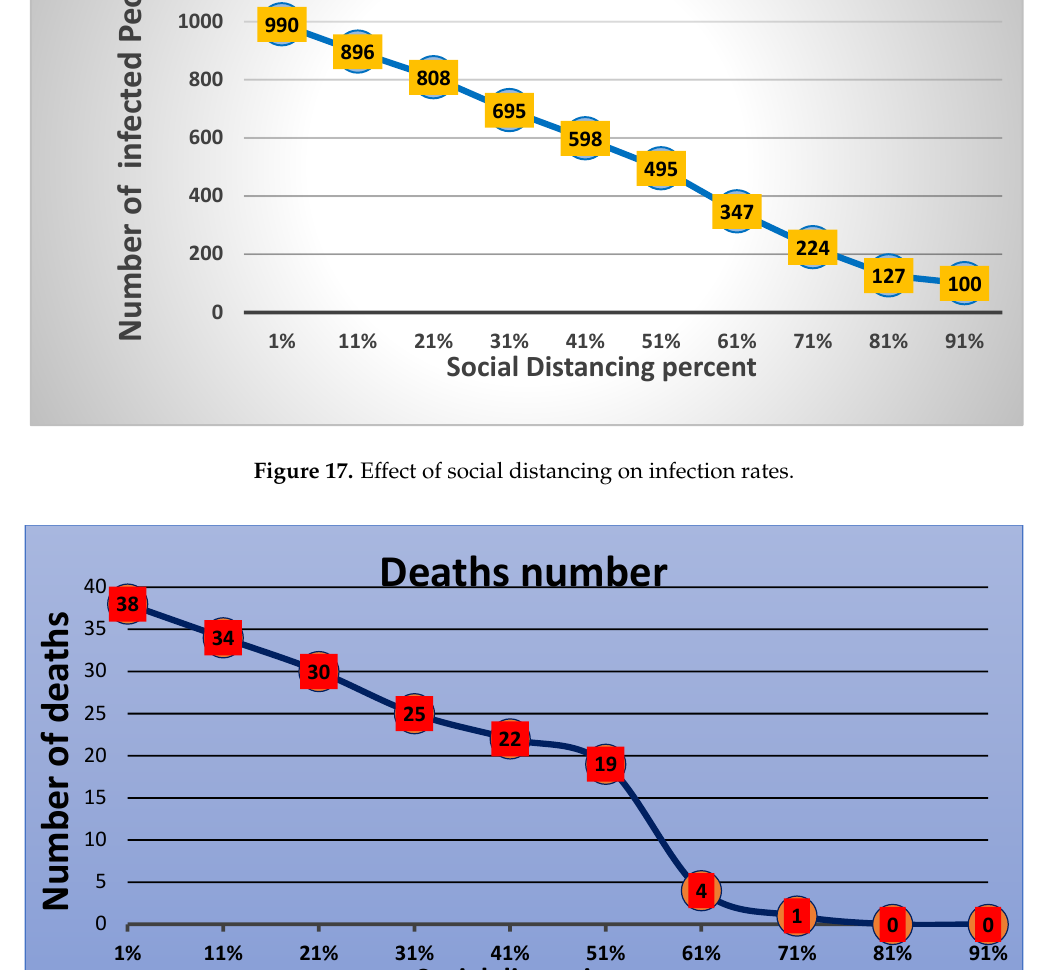
Figure 18. Number of deaths versus percentage of social distancing.